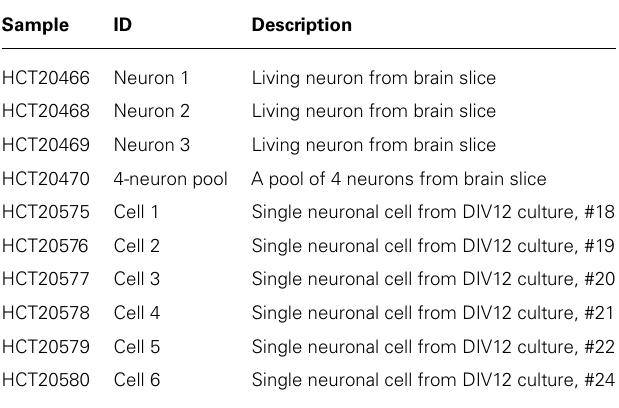
Table 1 |A list of samples used in our RNA-Seq experiment.The live neurons were retrieved from the same brain slice with normal electrophysiological properties.